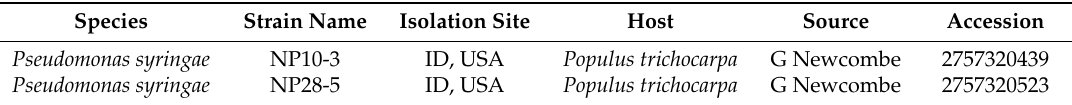
Figure 1. Maximum likelihood phylogenetic tree of amino acid sequences from 31 marker genes in Pseudomonas syringae pv. populus NP10-3 and NP28-5 (in bold) and selected representative P. syringae , with P. fluorescens Pf0-1 as out group. Branch lengths indicate expected substitutions per site and numbers above branches indicate ultrafast bootstrap support. Table 1. Bacterial strains reported for the first time in this study.